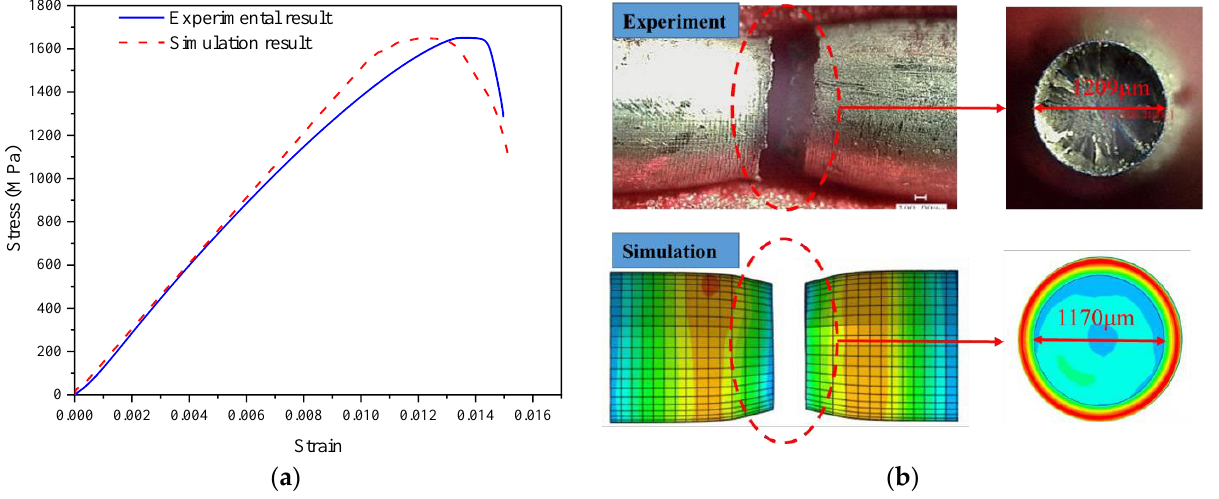
Figure 7. Comparison between simulation and experiment. ( a ) Tensile curves; ( b ) tensile fracture.